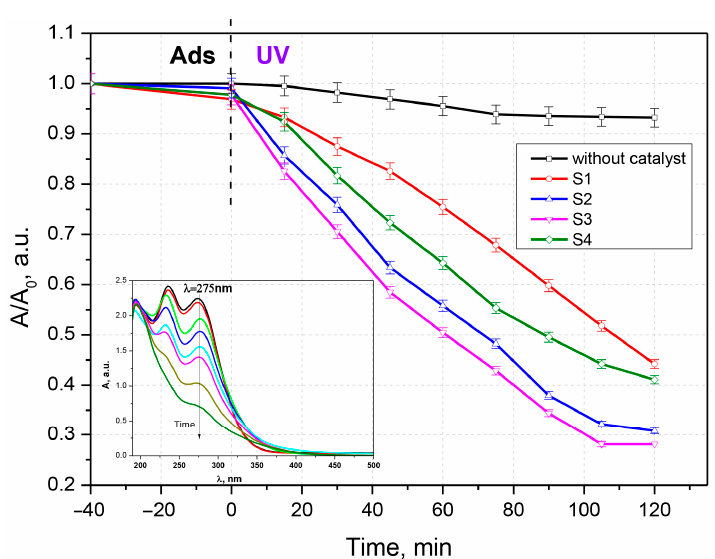
Figure 5. Photocatalytic degradation of chlortetracycline and time evolution of the UV-Vis absorp- tion spectrum of chlortetracycline.